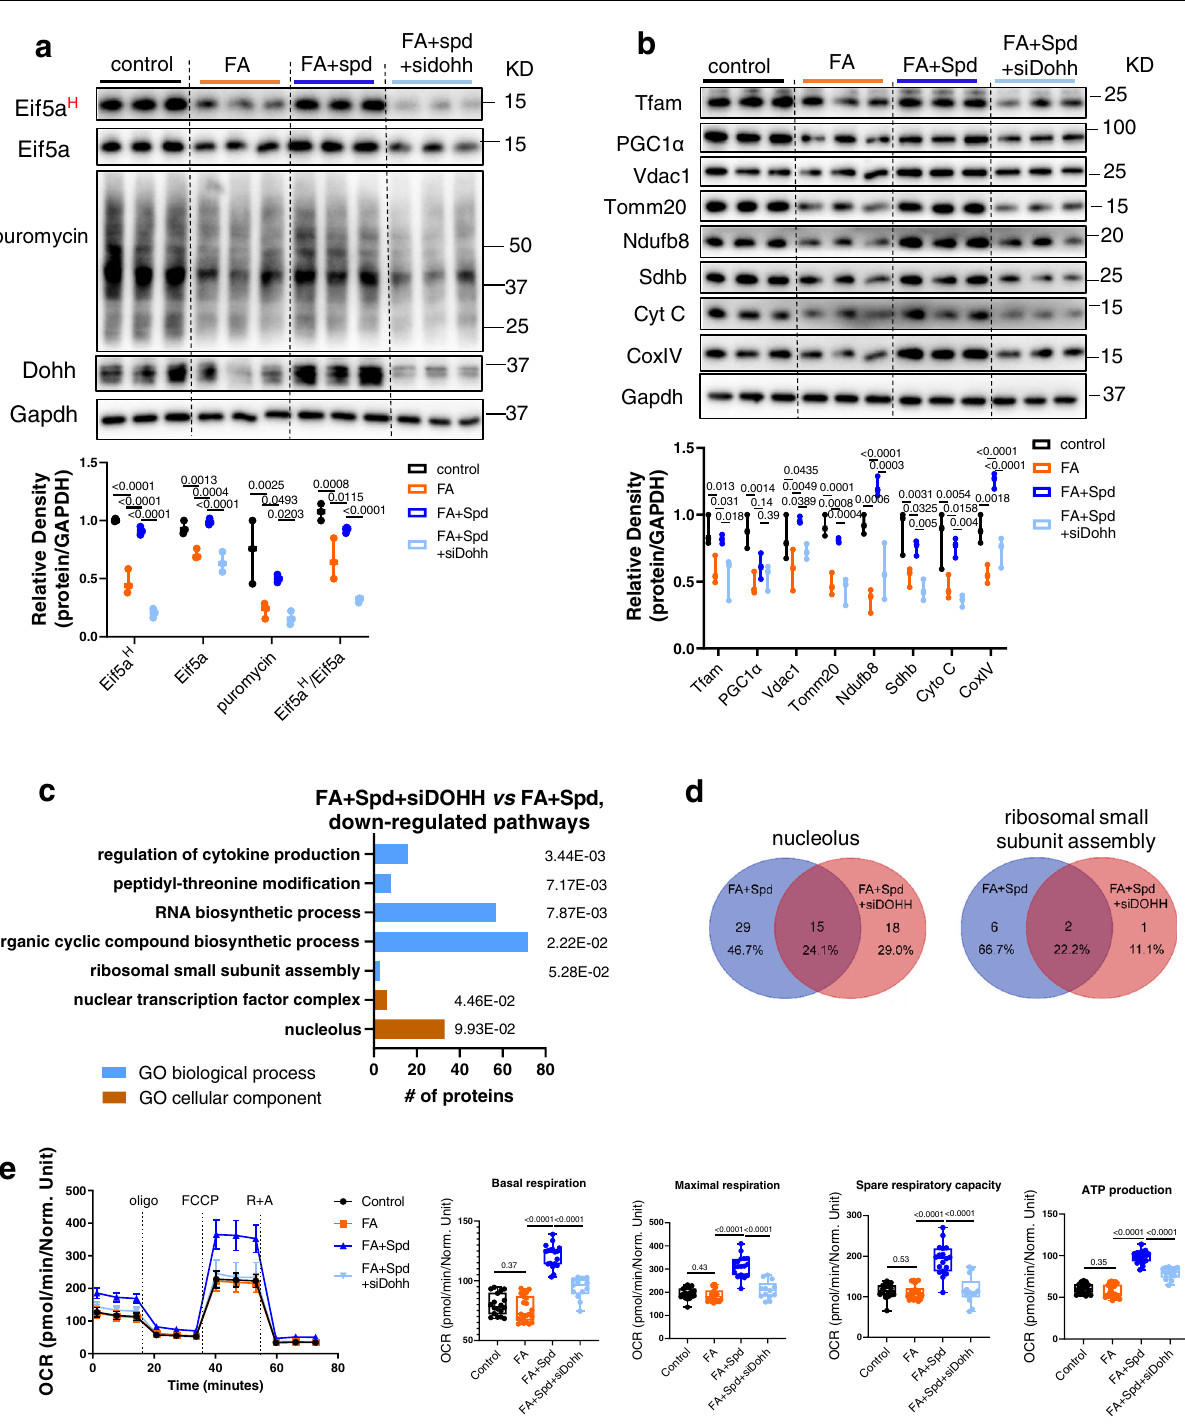
Fig. 4 | Spermidine rescued mitochondrial function in Eif5a H -dependent man- ner. a , b Western blot and densitometric analysis of Eif5a H , and puromycin cor- poration ( a , n =3), and mitochondrial proteins ( b , n =3). c Proteomics and gene ontology(GO)enrichmentanalysis(withcorrected p valueindicated onthebar)of downregulated proteins in FA+Spd+siDohh vs FA+Spd cells. A Bonferroni cor- rection was applied to correct for multiple testing. d Venn diagram showing the overlap of proteins under identi fi ed pathways in 4c and 3d. e Agilent Seahorse XF Mito StressTest of mitochondrialOXPHOS.AML12cells were fi rst transfected with